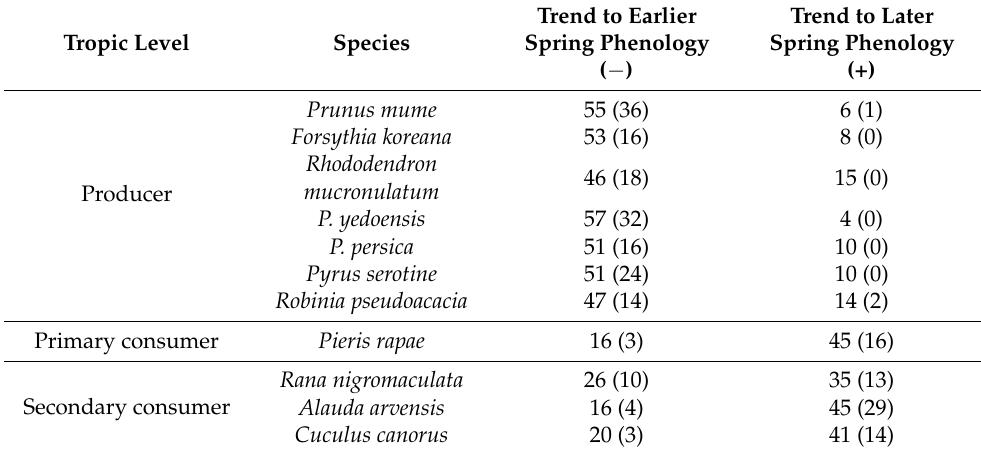
Table 2. Temporal trends and positive and negative slope coefficient values for the regression of phenology vs. year at each location of 61 sites during 1976~2015. The number in parentheses indicates the number of statistically significant values ( p < 0.05). Tropic Level Species